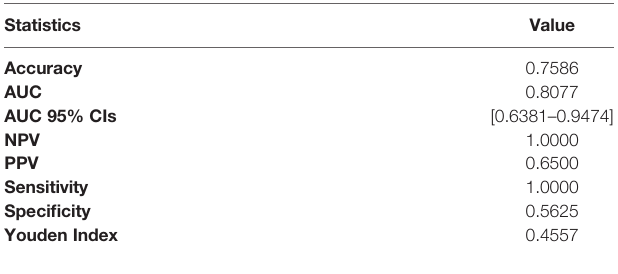
TABLE 7 | ROC analysis of ADC radiomics parameters.